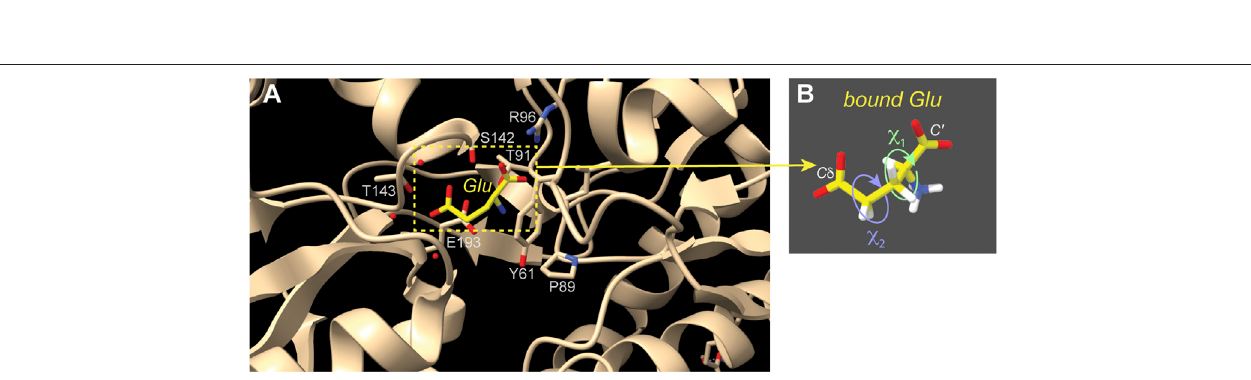
FIGURE5| Receptor-boundsubstratestudiedbytorsionanglessNMRmeasurements. (A) Thisimageshowsthestructureofthereceptor-boundGluaminoacid, based on X-ray crystallography (PDB 1FTJ) (Armstrong and Gouaux, 2000). Selected residues surrounding the bound substrate are indicated. (B) HCCH ssNMR analysisof χ 1 and χ 2 sidechainanglesenabledthemeasurementoftheGluresiduestructurewhileitwasboundtothecrystallineunlabeledprotein(Edwardsetal.,2010). This fi gure was prepared with UCSF ChimeraX (Pettersen et al., 2021).